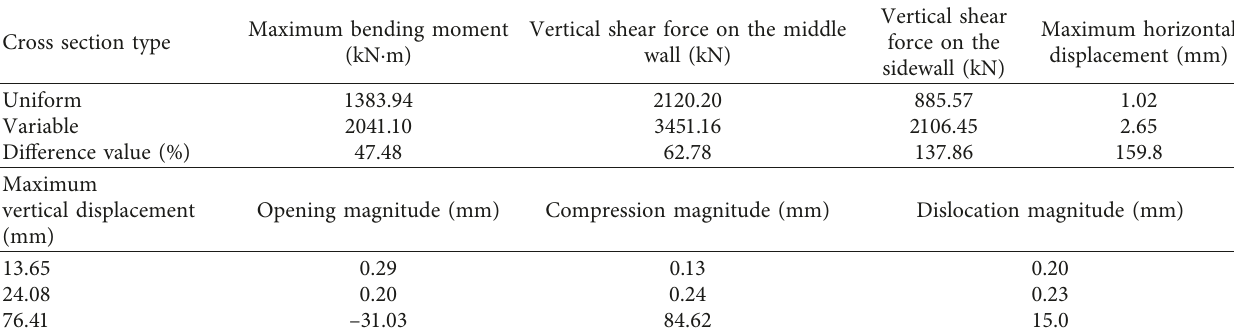
Table 2: The force-induced deformation of the Haizhu segment and joint